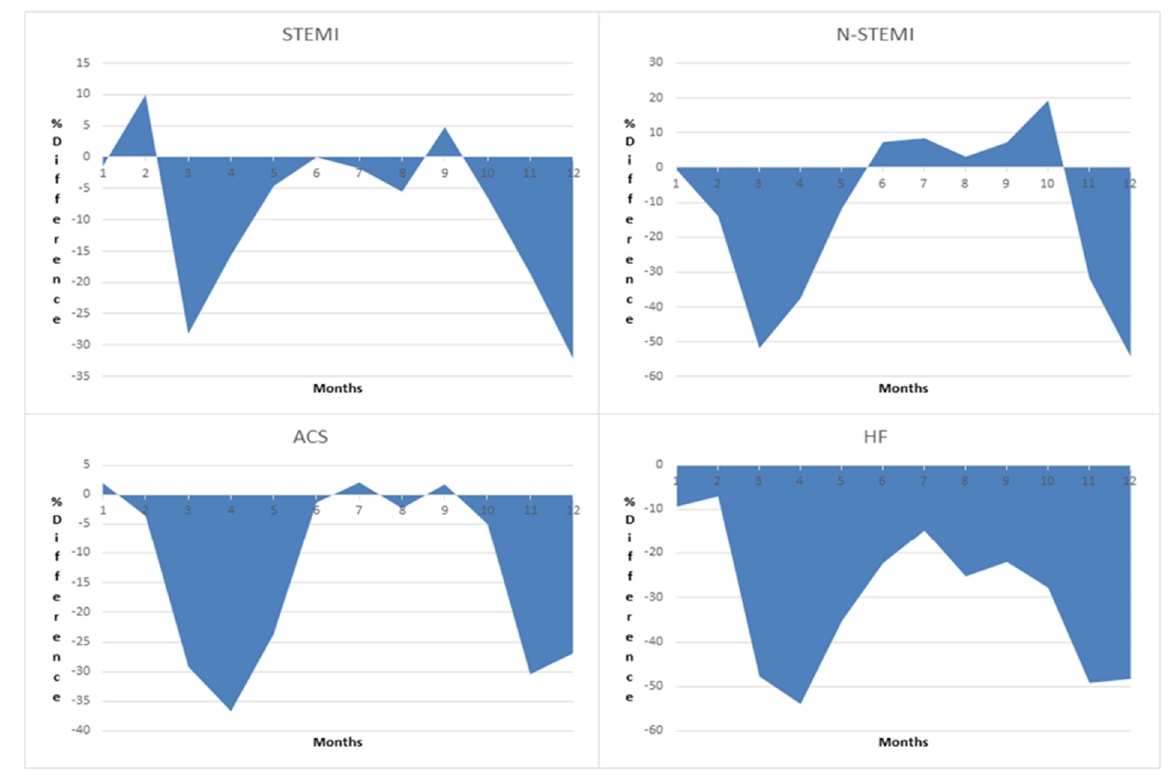
Figure 1. Monthly differences in CVD admissions by month in 2020.